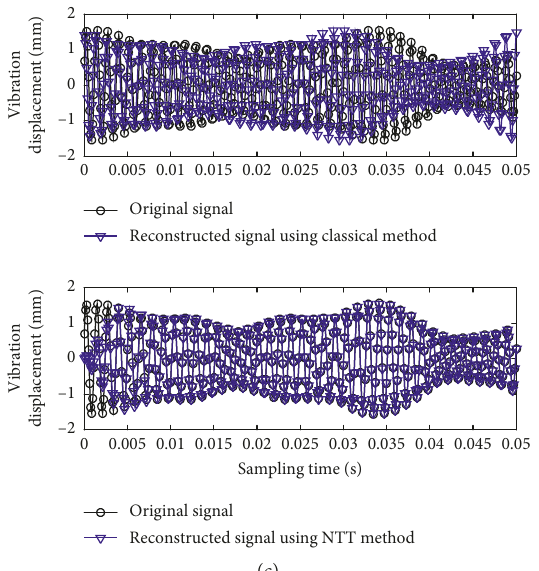
Figure 6: Comparisons of original and reconstructed vibration displacements: (a) URS � 3.16%; (b) URS � 6.33%; (c) URS � 0%.